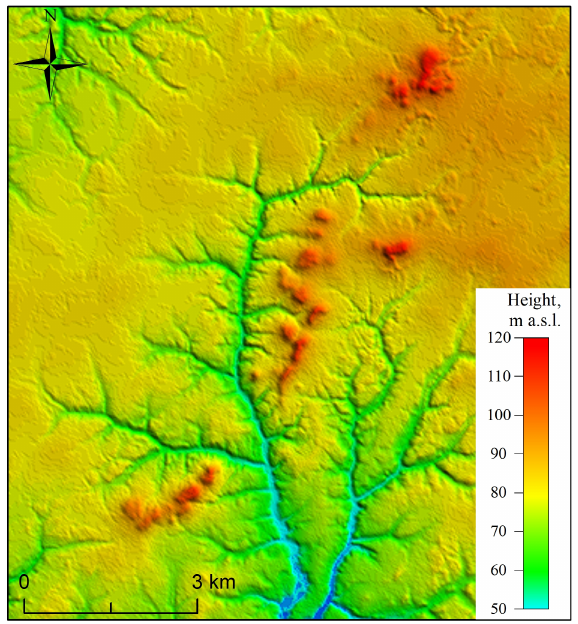
Figure 11. Kame-like features, TanDEM-X DEM © DLR, 26m/px.